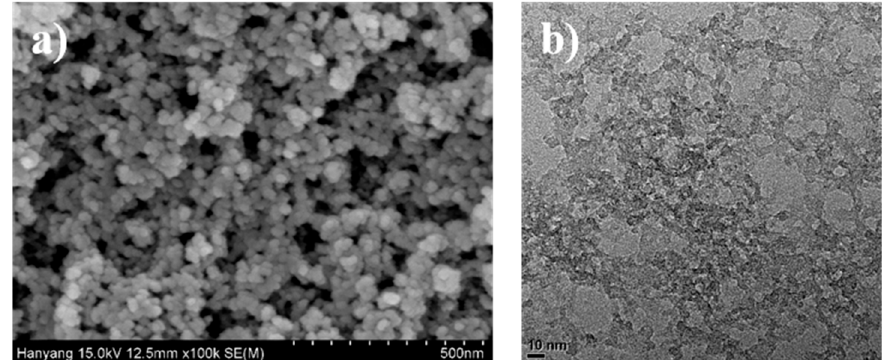
Figure 6. ( a ) Field emission scanning electron microscopy (FE-SEM) images of the rice-husk-based silica aerogel at a magnification of ×100,000; ( b ) transmission electron microscopy (TEM) images at a magnification of ×100,000.